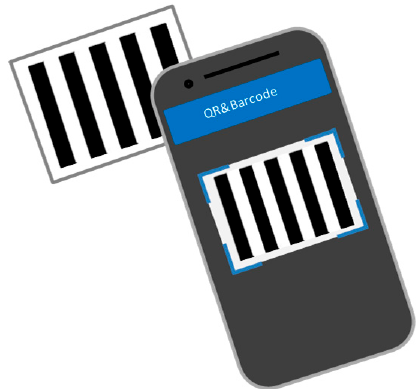
Figure 4. Device schematization.